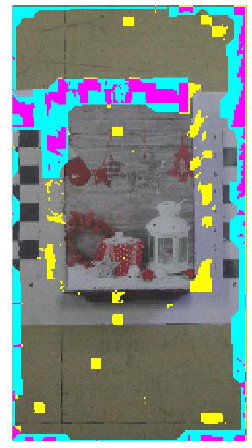
Figure 7. Comparison between holes in the orthophotos produced by MAGO and Agisoft Metashape©: yellow, cyan and magenta represent the holes produced by only MAGO, only Agisoft Metashape©, and both,